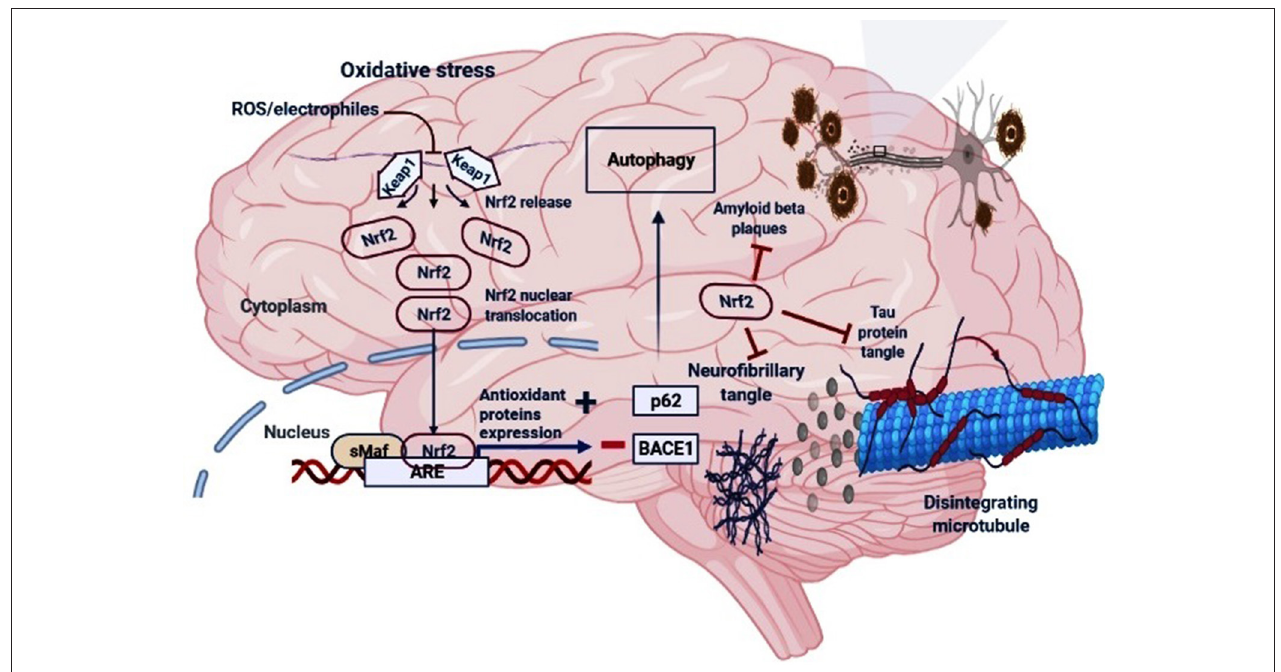
FIGURE 2 | The regulatory mechanism of Nrf2 in AD. Under oxidative stress (electrophiles or ROS conditions) Nrf2 is released from Keap1-Cul3-RBX1 complex for translocation into the nucleus followed by its heterodimerization with sMaf which leads to its binding with the antioxidant response elements (AREs), and transcription of ARE-driven genes. Nrf2 activation may increase the levels of p62 which is responsible for the autophagic process and inhibit the BACE1 that generate amyloid- β peptides in the neurons. Moreover, Nrf2 counteracts neurofibrillary, tau proteins tangle and amyloid- β